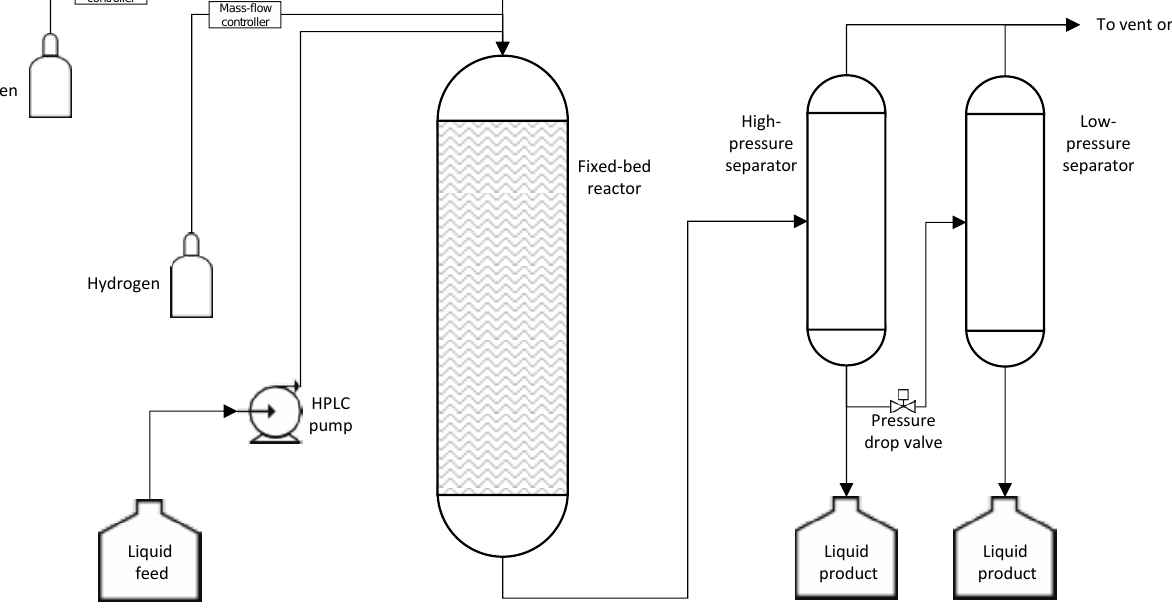
Figure 1. Laboratory fixed-bed unit flow-chart.